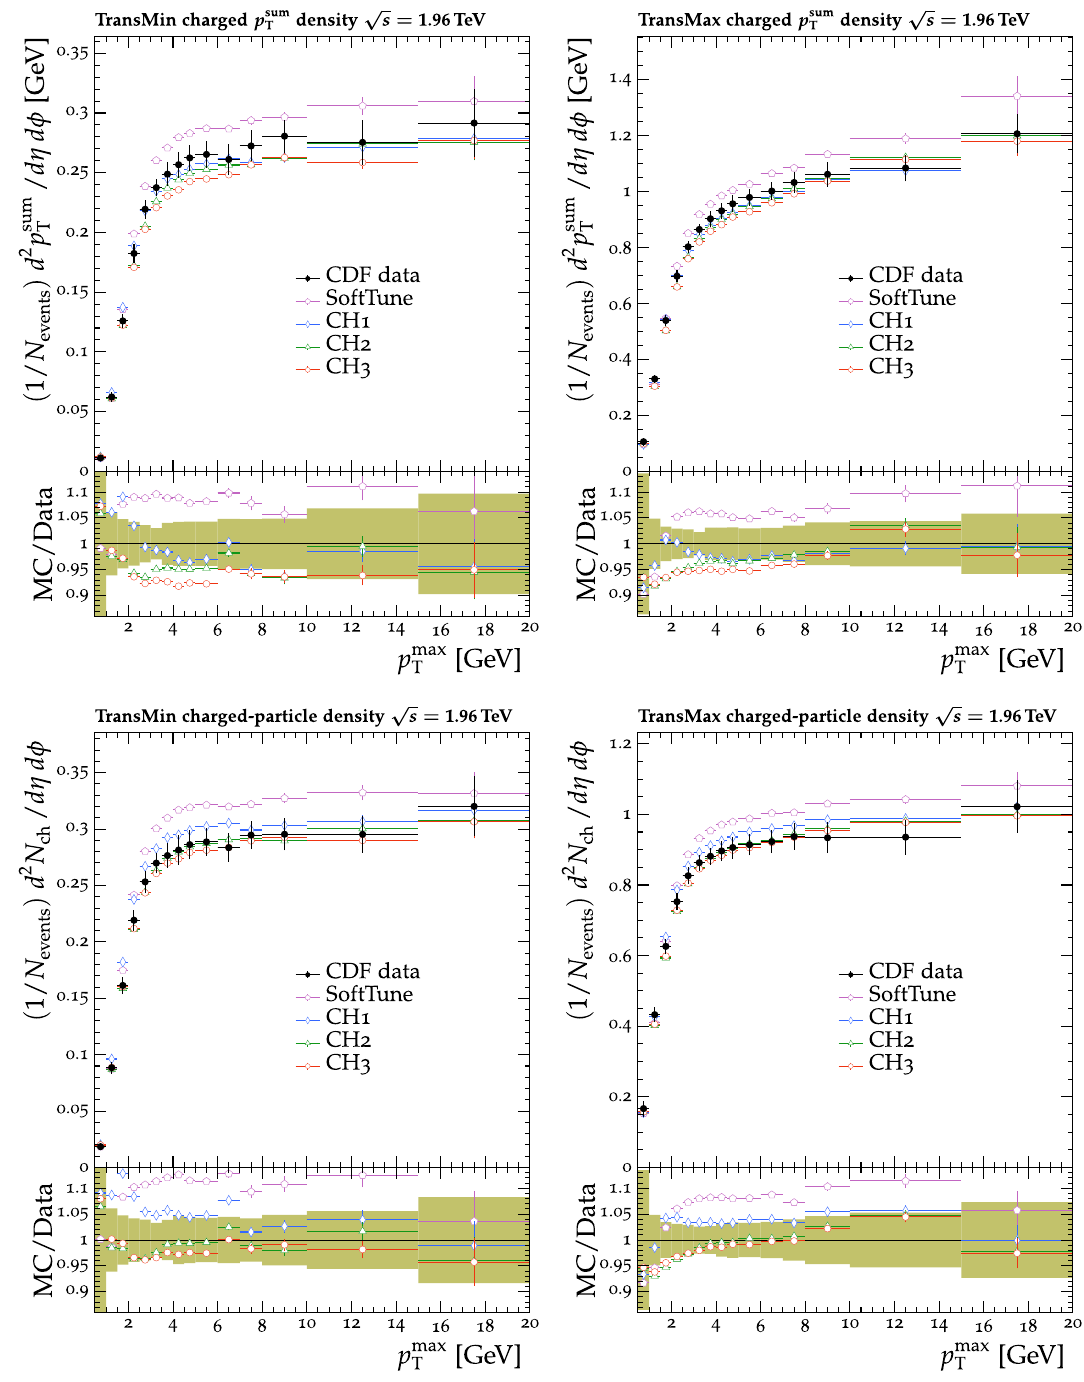
Fig. 6 The p sum (upper) and N ch (lower) density distributions in the T transMin (left) and transMax (right) regions, as a function of the p T of the leading track, p max [31]. CDF MB data are compared with the pre- T dictions from herwig 7, with the SoftTune and CH tunes. The coloured